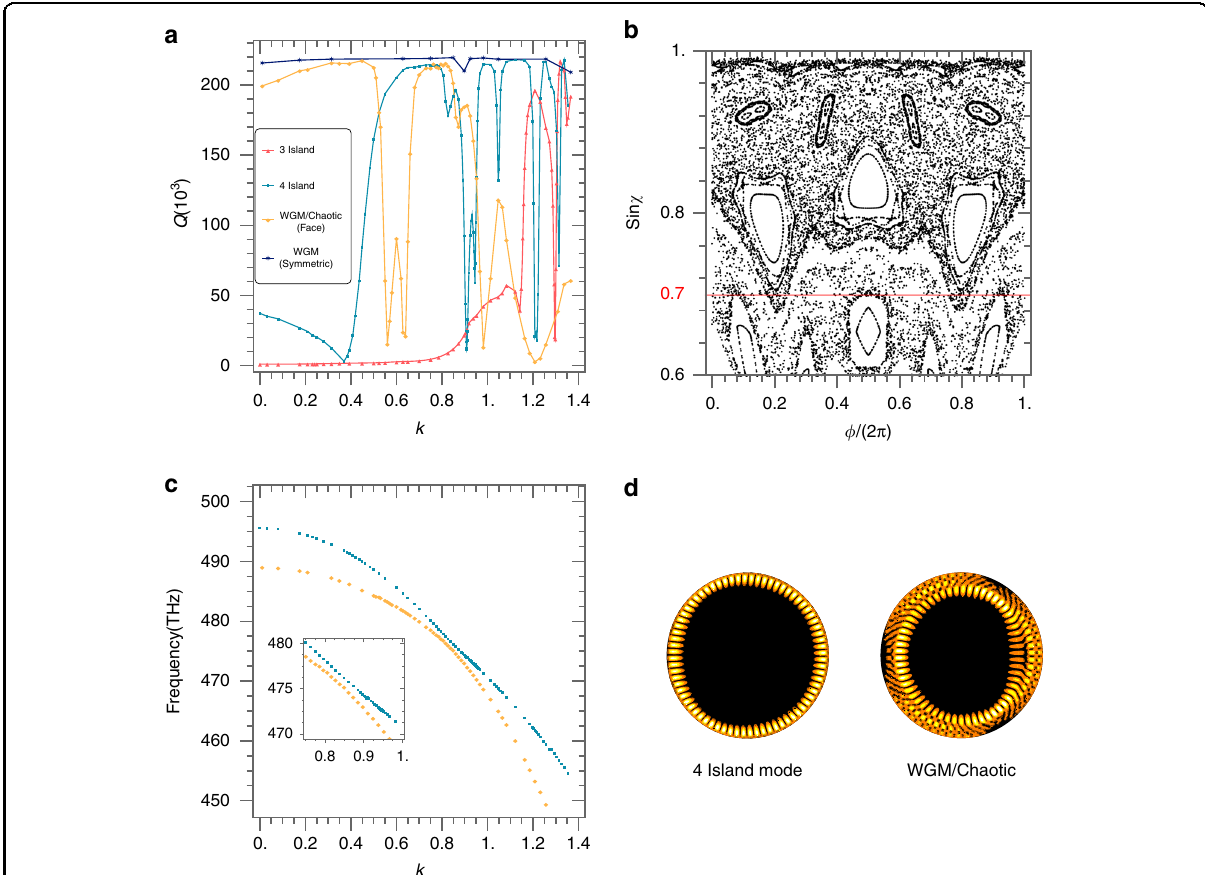
Fig. 4 Curvature-mediated photon-lifetime engineering. a Q-factor vs. k for the 4-period (green), the 3-period (red), the WGM (yellow, which becomes a hybrid 4-period chaotic mode at k > 0.81) of the Face cavity and the WGM of a symmetric cavity (blue). b PSOS of the Face cavity with k = 1.16. c Mode frequency of the 4-period island and the WGM showing strong coupling to form hybrid modes. The inset is an enlarged view around the anticrossing point. d Spatial fi eld distribution of the hybrid 4-period island (left) and WGM-chaotic (right) modes at k =